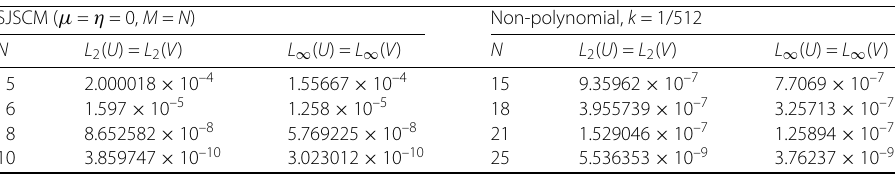
Table 15 L 2 and L ∞ error norms for u ( x , t ) = v ( x , t ) of Example 3 when 0 ≤ x ≤ 3, α 1 = α 2 = 0.01 SJSCM ( μ = η = 0, M = N )